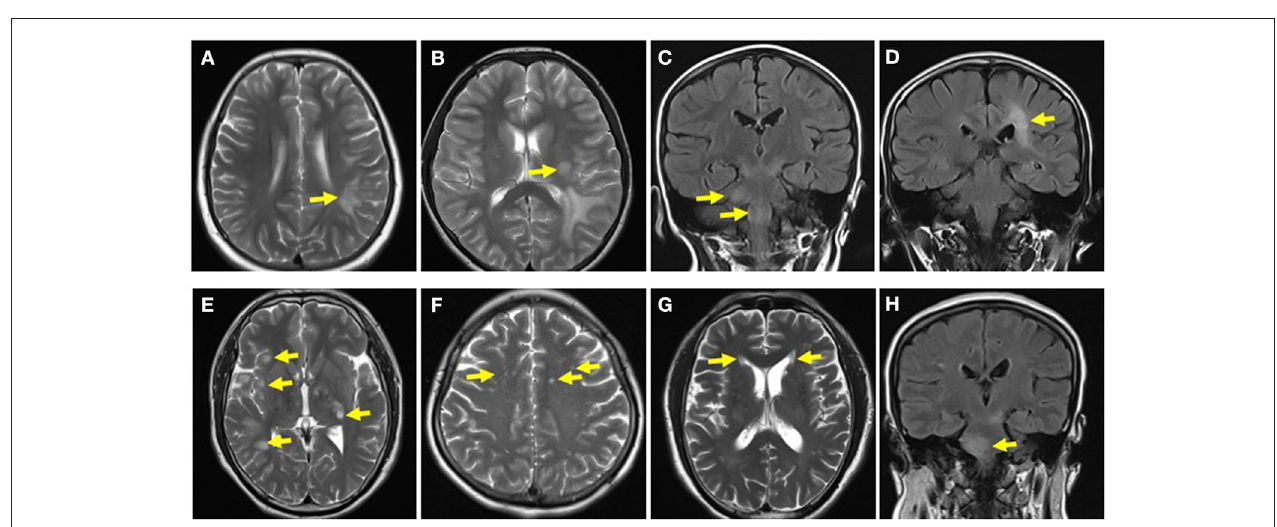
FIGURE 3 | Brain MRI of pediatric and adult patients. (A) Subcortical white matter lesion in a pediatric patient. (B) Deep gray matter in a pediatric patient. (C) Infratentorial lesion in a pediatric patient. (D) Periventricular lesion in a pediatric patient. (E) Subcortical white matter and deep gray matter lesions in an adult patient. (F) Centrum semiovale lesions in an adult patient. (G) Periventricular lesions in an adult patient. (H) Infratentorial lesions in an adult